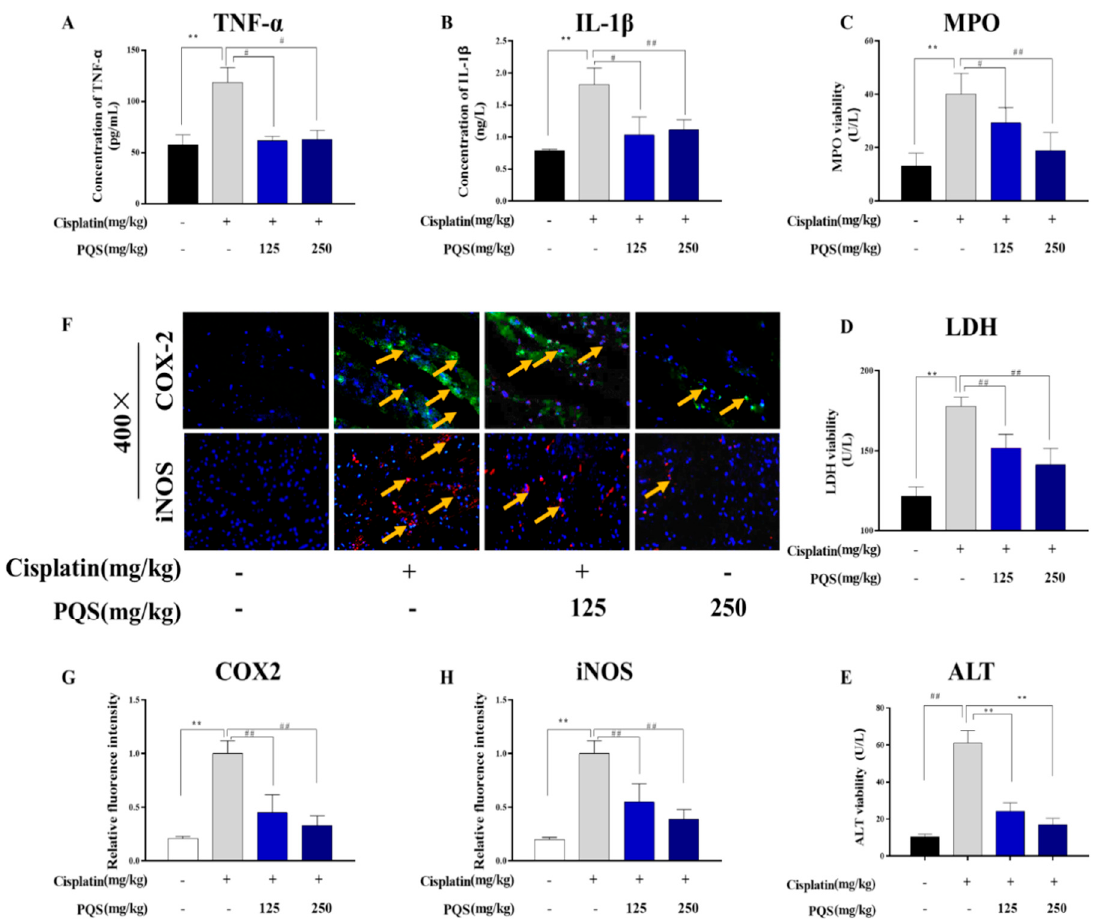
Figure 4. E ff ect of PQS on cisplatin-induced changes in inflammatory markers in heart tissues of mice. ( A ) Tumor necrosis factor-a (TNF- α ); ( B ) Interleukin-1 β (IL-1 β ); ( C ) Myeloperoxidase (MPO) activity; ( D ) Lactate dehydrogenase (LDH); ( E ) ALT activity; ( F ) PQS exerted great changes on expression of COX-2 and iNOS in heart tissues, the expression levels of COX2 (Green) and iNOS (Red) in tissue section isolated from di ff erent groups were assessed by immunofluorescence. ( G ) Quantitative analysis of scanning densitometry for cleaved COX-2 ( H ) Quantitative analysis of scanning densitometry for cleaved iNOS. All data were expressed as mean ± S.D. ** p < 0.01 comparing with normal group. # p < 0.05 or ## p < 0.01 comparing with cisplatin